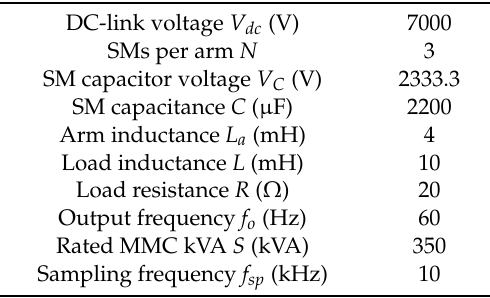
Table 1. Simulation parameters of the single-phase MMC.